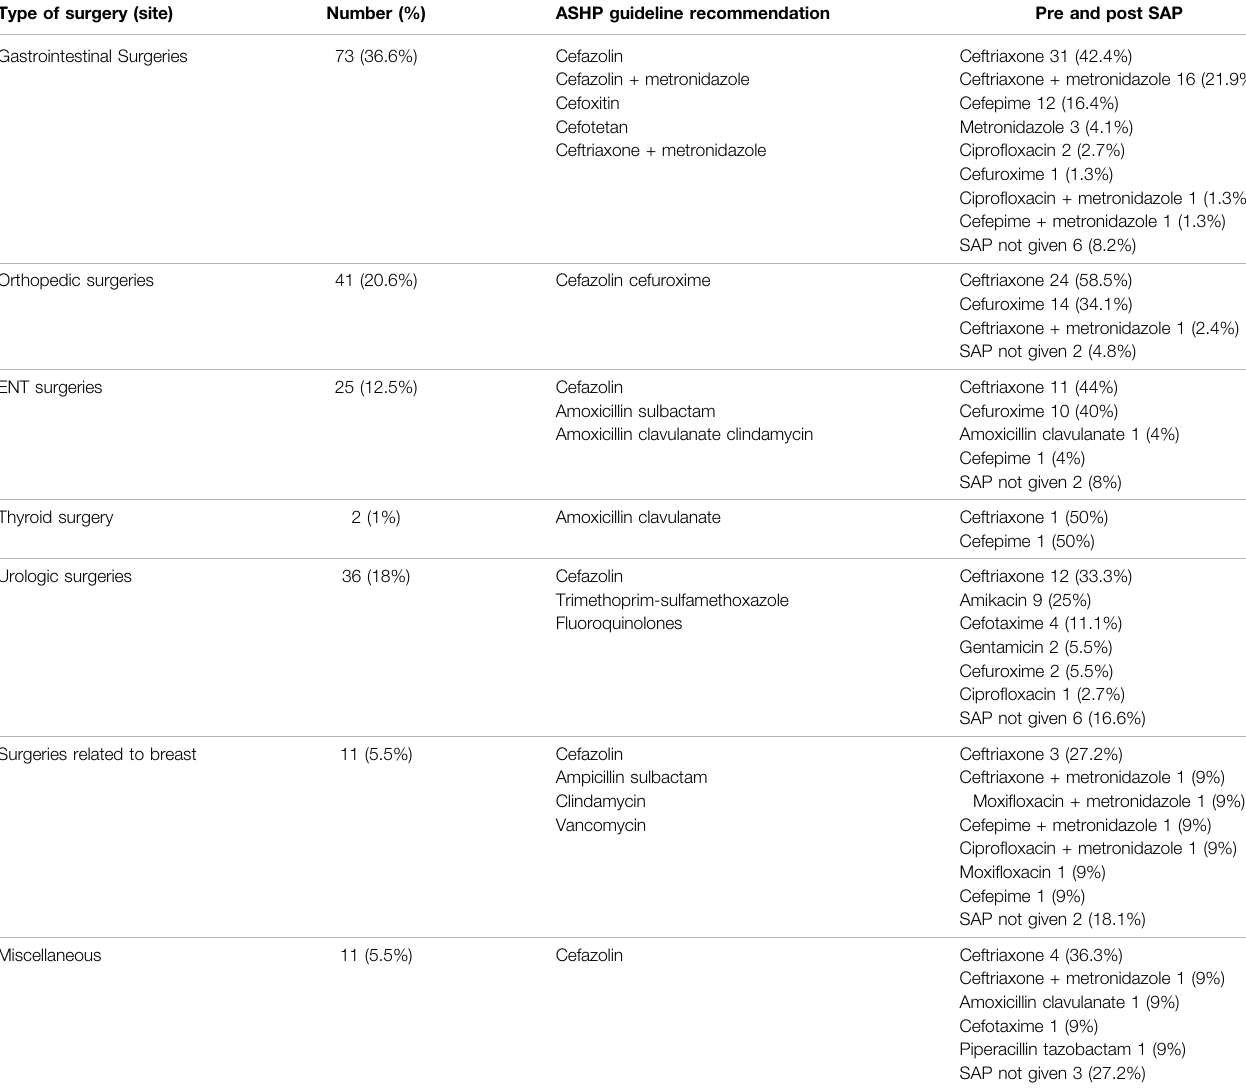
TABLE 5 | Surgical site and antimicrobials administered compared with guidelines.